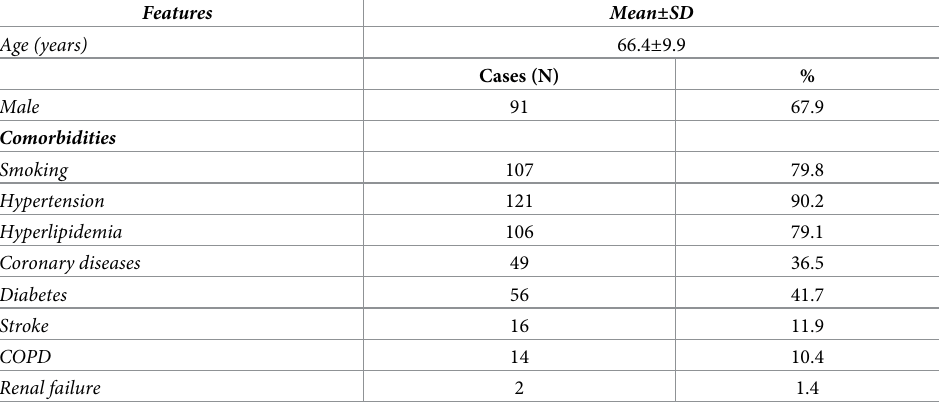
Table 1. Demographic data and